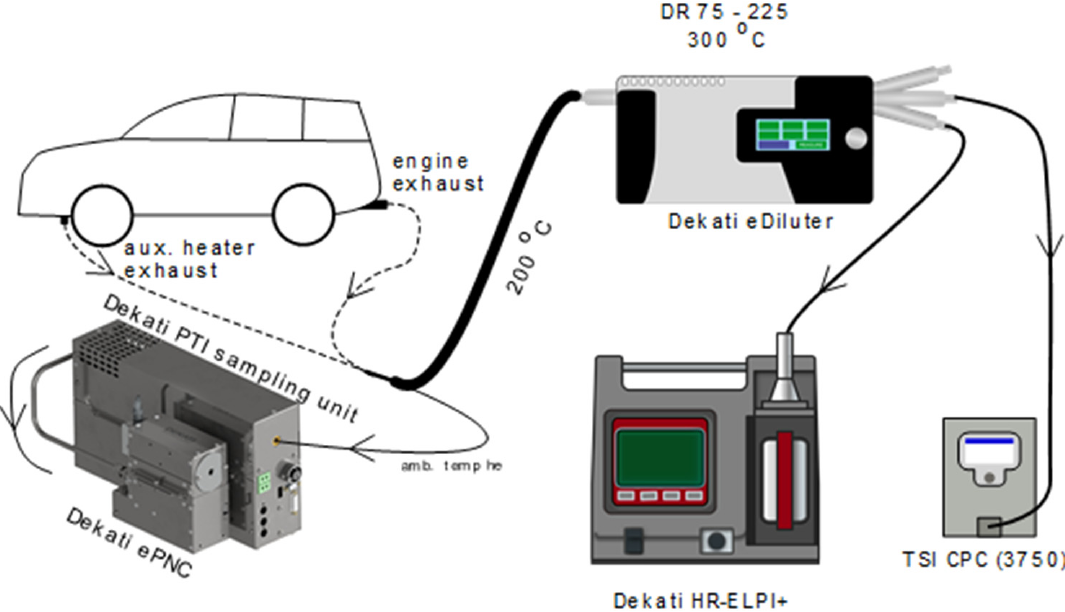
Figure 1. Experimental setup with sampling locations (aux-heater exhaust pipe and engine exhaust pipe), sampling parameters and aerosol instrumentation.